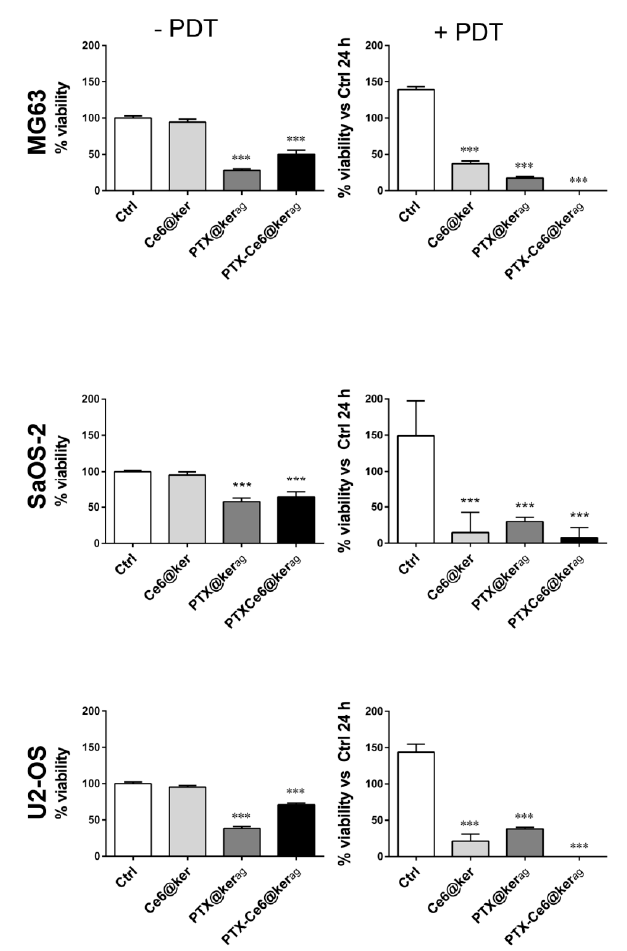
Figure 4. Impact of medium dosage of PTX-Ce6@Ker ag on OS cells’ viability in a 2D system, and the additive effect of PTX and photodynamic therapy (PDT) on OS cell viability. OS cell lines were treated for 24 h with Ce6@ker, PTX@ker ag , or PTX-Ce6@ker ag at medium concentration. The graphs show